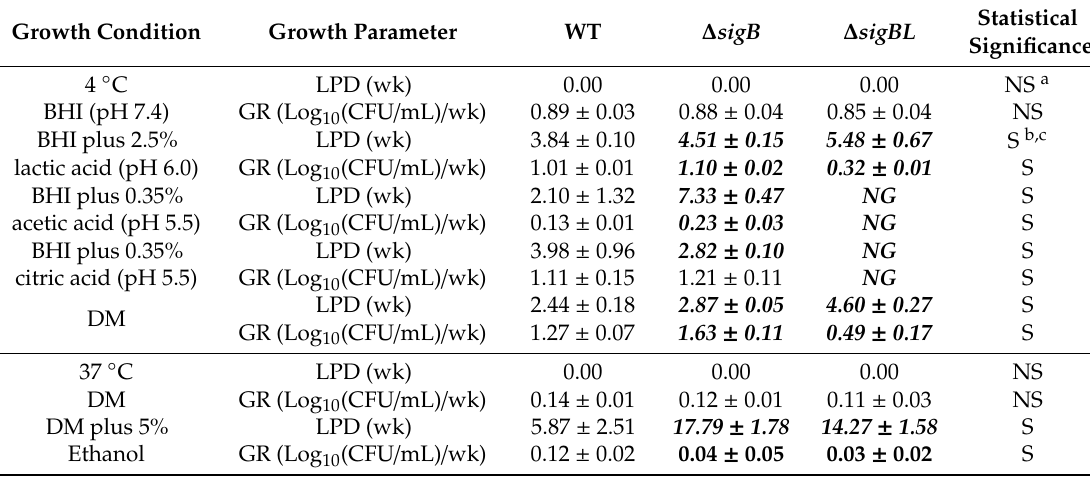
Table 1. Growth parameters determined for Listeria monocytogenes ∆ sigB, ∆ sigBL , and parental EGD-e strain under di ff erent conditions in brain heart infusion broth (BHI) and defined medium (DM) at 4 and 37 ◦